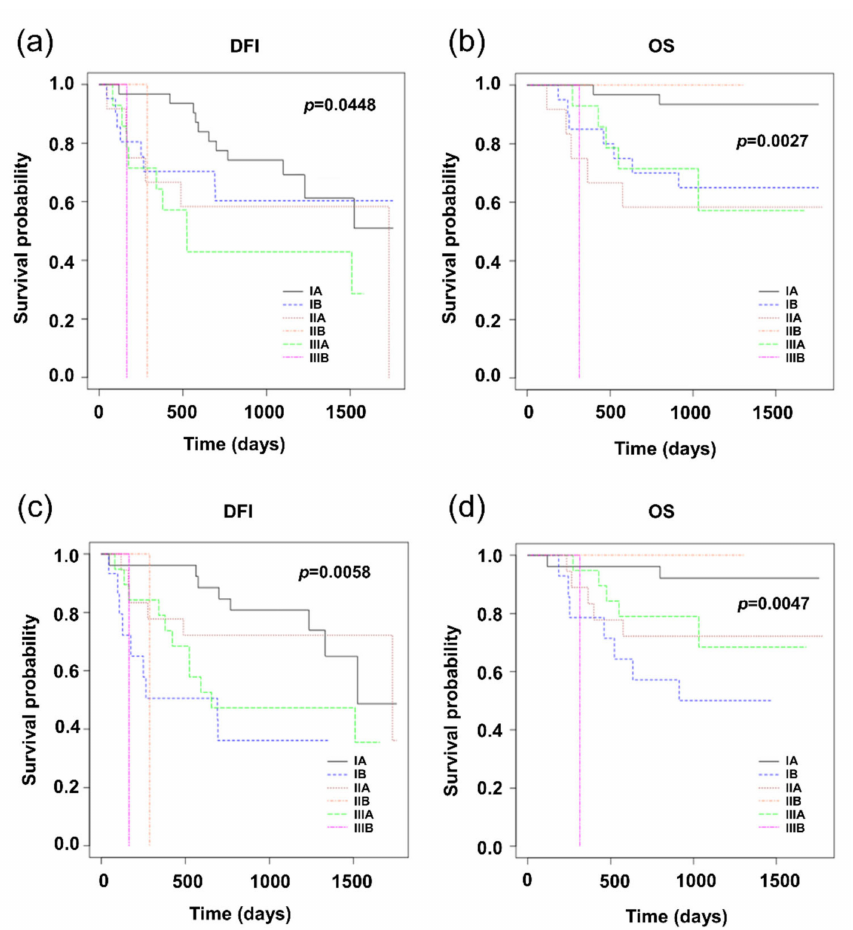
Figure 3. Kaplan–Meier survival distribution functions of NSCLC patients stratified according to stage of disease. ( a ) Disease-free survival (DFI) of patients classified according to the results of H&E; ( b ) overall survival (OS) of patients classified according to the results of H&E; ( c ) disease-free survival (DFI) of patients classified according to the results of OSNA; ( d ) overall survival (OS) of patients classified according to the results of OSNA.